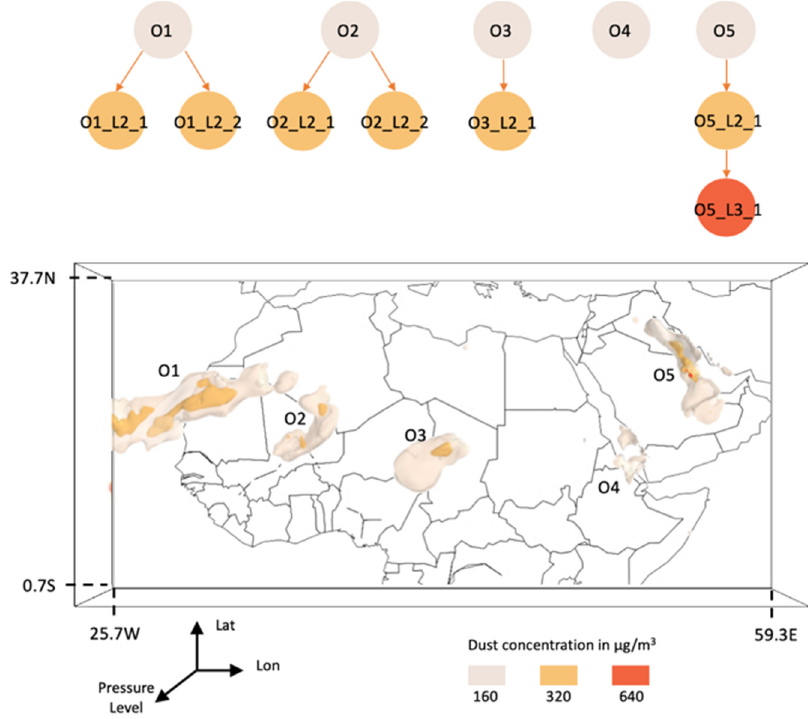
ff erent levels of